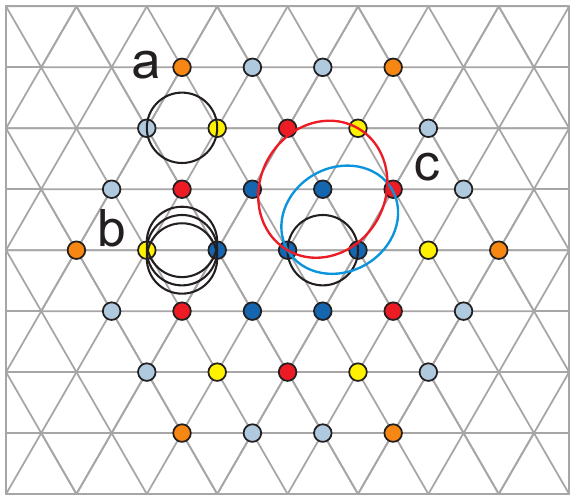
Figure 3. Schematic presentation of exemplary commensurability patterns acc. to Equation (9) for single-loop cyclotron orbit and ν = 1 ( a ), three-loop cyclotron orbit with all loops nested with nearest neighboring electrons and ν = 1 , i.e., x 1 = x 2 = x 3 = 1, q = 3 in Equation (9) ( b ) and three-loop 3 cyclotron orbit with loops nested with next-nearest electrons, i.e., for x 1 = 1, x 2 = 3 and x 3 = 4, q = 3 in Equation (9), for which ν = ( 1/1 + 1/3 + 1/4 ) − 1 = 12 (cf. Figure A2 for the explanation of 19 values for x i displaying fractions of succeeding generations of next-nearest neighbors in the Wigner lattice) ( c